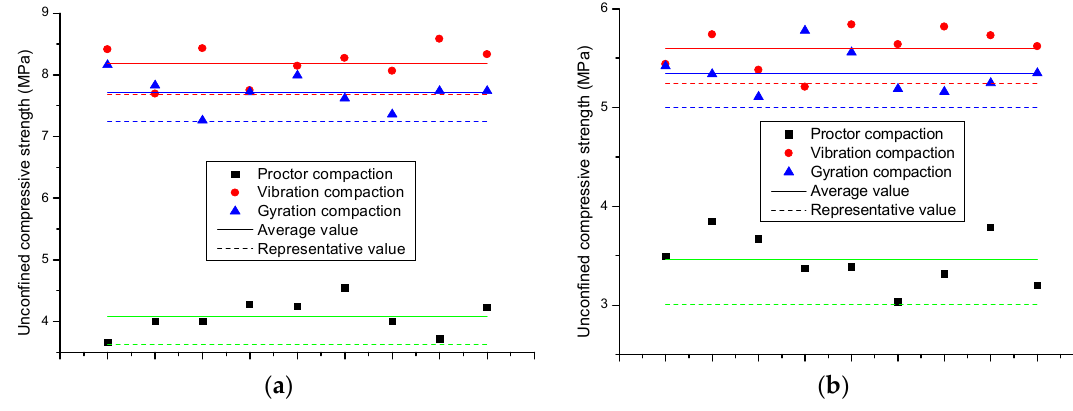
Figure 12. Unconfined compressive strength of ( a ) Aggregate A and ( b ) Aggregate B.